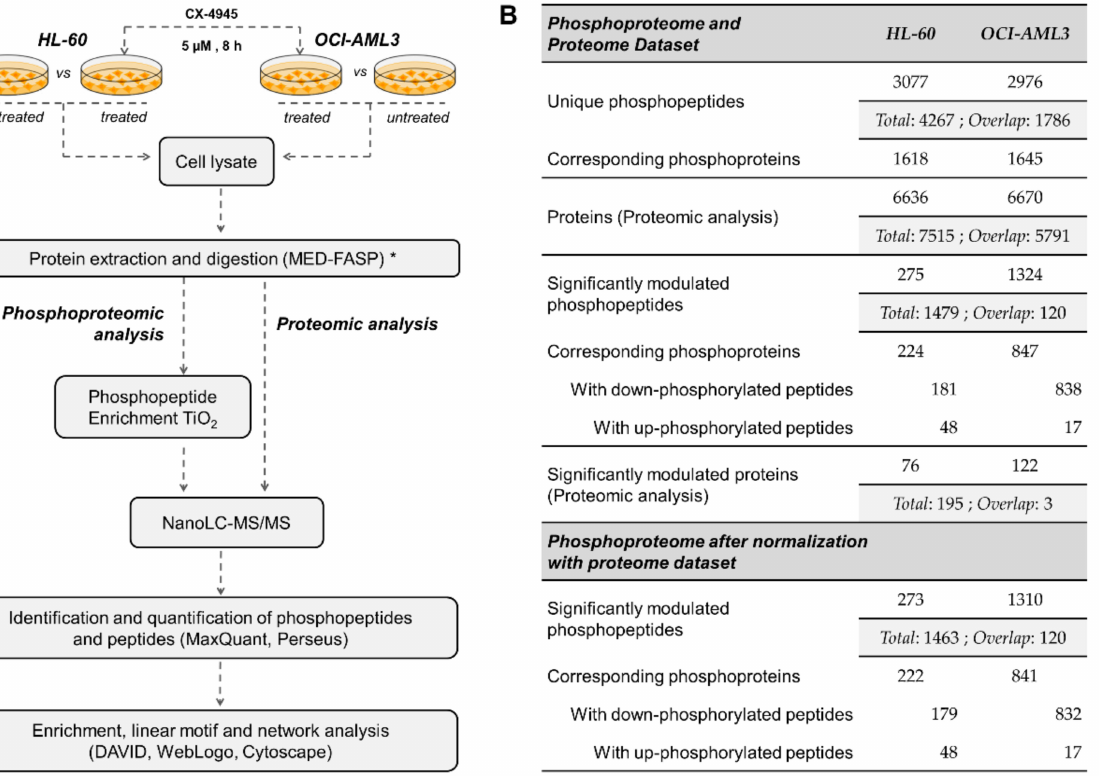
Figure 1. Phosphoproteomic and proteomic analysis of human AML cells treated with the CK2 inhibitor CX-4945: ( A ) Work- flow for the exploration of phosphorylation changes induced in HL-60 and OCI-AML3 cells after treatment with CX-4945. Three biological replicates of each group were evaluated; ( B ) Number of identified and significantly modulated phospho- peptides and proteins in each AML cell line. Phosphoproteomic results are showed before and after normalization with the proteome dataset. (*) MED-FASP: multienzyme digestion filter-aided sample preparation